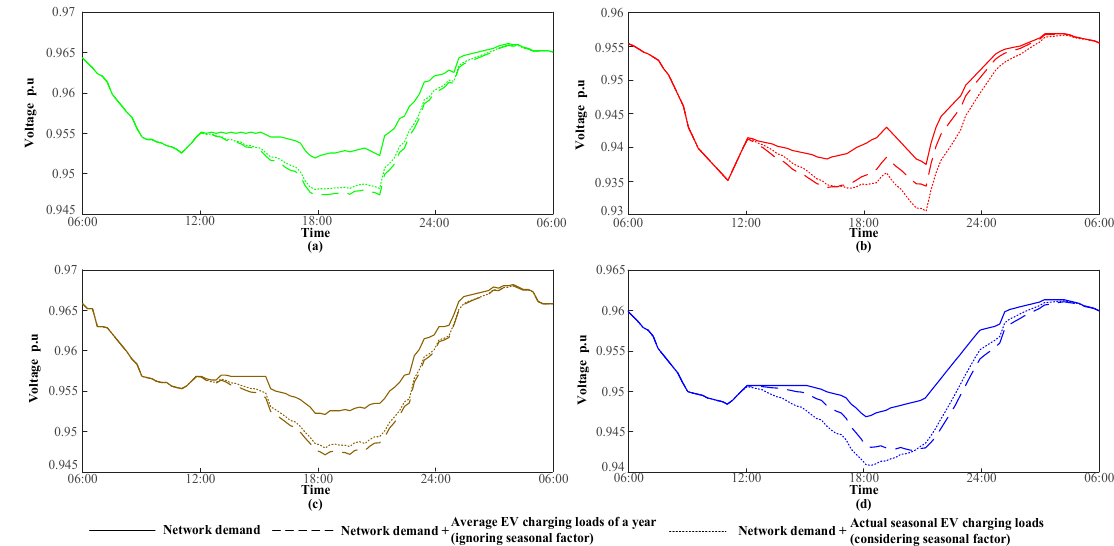
Figure 9. Daily node voltage curves of the given network without considering any optimal charging strategy; ( a ) spring, ( b ) summer, ( c ) autumn, ( d ) winter.